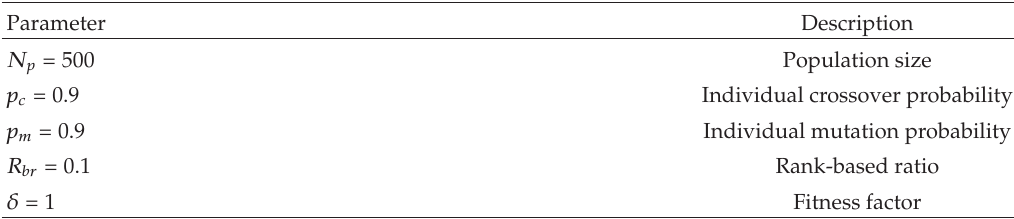
Table 1: List of input data to the